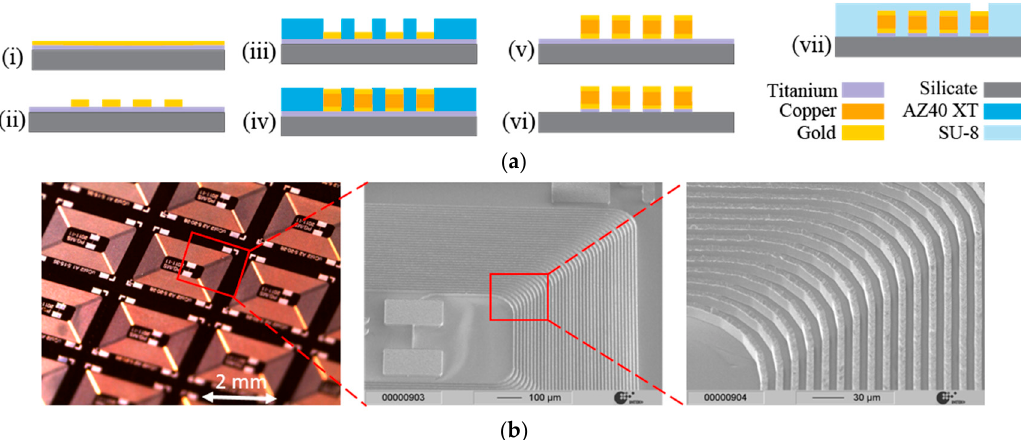
Figure 2. ( a ) Microcoil fabrication sequence; ( i ) Seed layer sputter deposition; ( ii ) Ion beam etching; ( iii ) 30 μ m AZ40XT photolithography; ( iv ) Cu + Au electroplating; ( v ) Resist strip in megasonic bath; ( vi ) Wet selective seed layer etching; ( vii ) SU-8 encapsulation; ( b ) 22- μ m-high free-standing microcoils with 5 μ m linewidth and 15 μ m spacing after etching. Vertical layer dimensions in ( a ) are not to